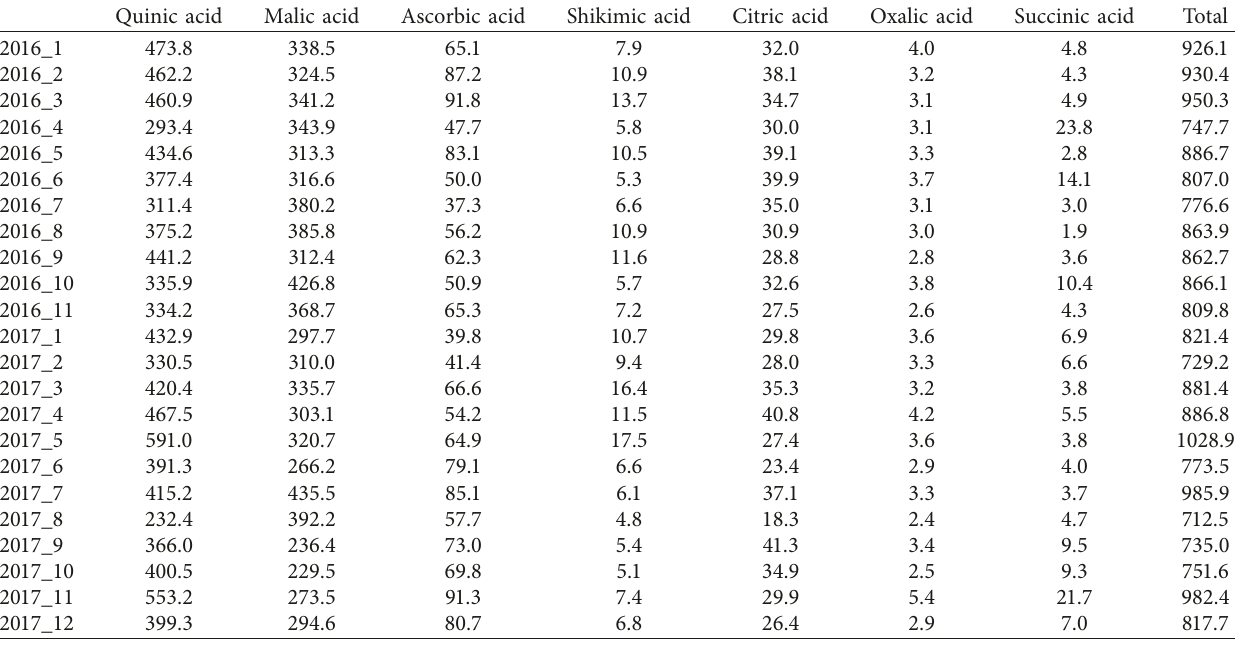
Table 2: Organic acid content (mg/100 g FW) in 23 samples of aronia berries.